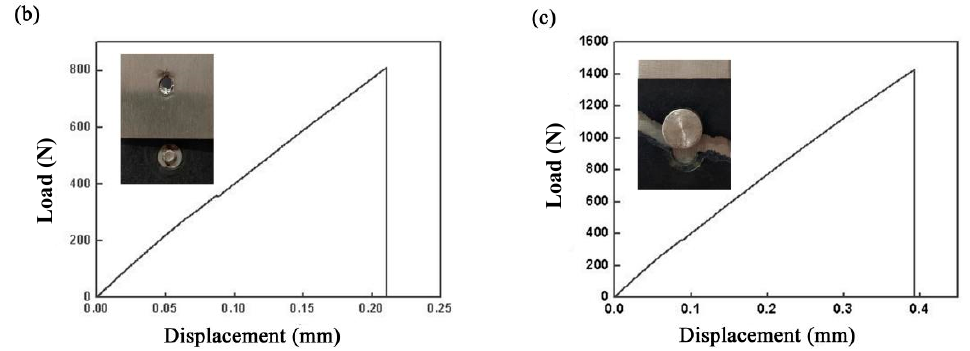
Figure 6. Tensile curves of ( a ) the FRP plate with a hole, ( b ) the rivet I joint, and ( c ) the rivet II joint.